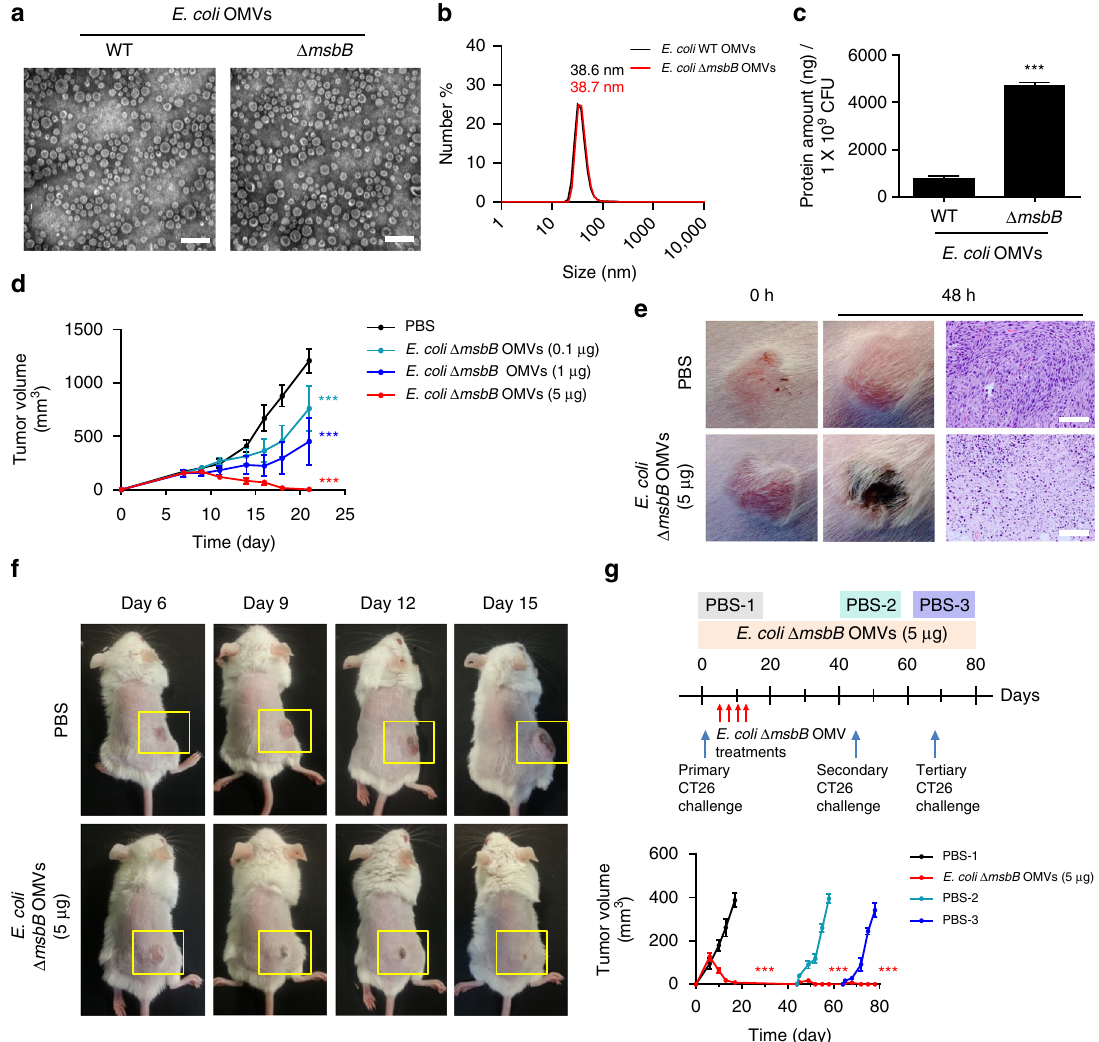
Fig. 1 Treatment of outer membrane vesicles (OMVs) induces complete regression of tumors. a Transmission electron micrograph image of E. coli W3110 wild type-derived OMVs (WT OMVs) and E. coli W3110 msbB mutant-derived OMVs ( Δ msbB OMVs). Scale bars , 100 nm. b Size distribution of E. coli W3110 WT and Δ msbB OMVs measured by dynamic light scattering analysis ( n = 5). c Production yield of E. coli W3110 WT and Δ msbB OMVs from 1 × 10 9 CFUs bacteria in terms of total protein amount ( n = 5, three independent experiments). d Tumor volume of mice bearing CT26 murine colon adenocarcinoma measured after E. coli Δ msbB OMV treatments with various amounts (total n = 14 mice per group, two independent experiments). E. coli Δ msbB OMVs were injected intravenously four times from day 6 with 3 days intervals. e Picture of tumor and tumor tissue histology 48 h after single PBS or Δ msbB OMV (5 μ g in total protein amount) injection. Scale bars , 50 μ m. f Picture of mice bearing tumor after PBS or Δ msbB OMV (5 μ g in total protein amount) treatments. Yellow box indicates tumor sites. g Mice treated with OMV (5 μ g in total protein amount) with complete tumor regression were